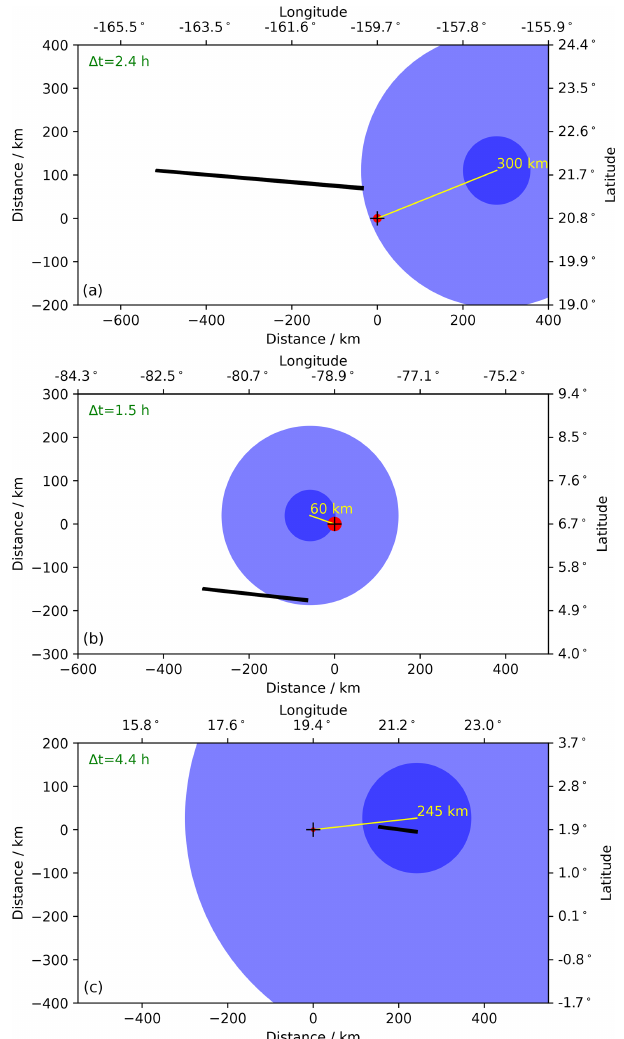
Figure 13. Results of the sprite transport and dispersion calcula- tions. From top to bottom: sprite event A, B, and C (Table 1). The axes give latitude and longitude of the scenes as well as the merid- ional and zonal distances from the initial sprite locations (all three maps display the same area size). The red circles depict the initial sprite cross sections derived from the observed horizontal widths of the sprites. The blue circles indicate the sprite cross sections at the times of the SMILES measurements. The large/small blue cir- cles correspond to the fast/slow diffusion scenario. The black lines show the fields of view of the SMILES measurements (between the tangent points and an altitude of 81.5km). The yellow lines show the displacement of the sprite centres, and (cid:49)t is the time difference between the sprite occurrence and the SMILES